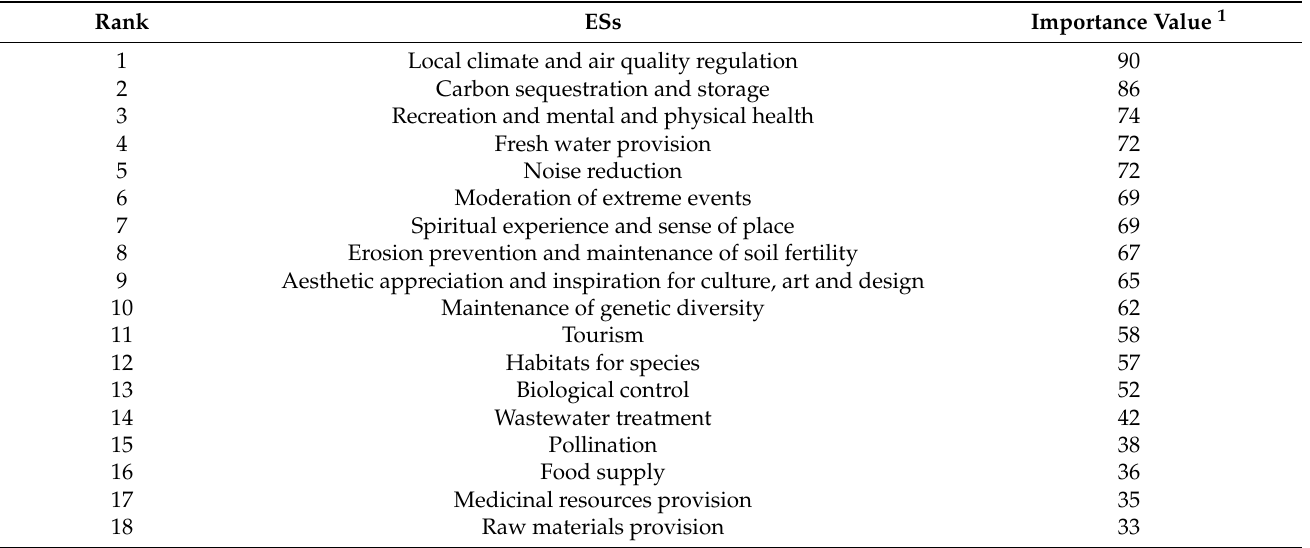
Table 3. Ranking the importance value of ESs in the second experts’ online